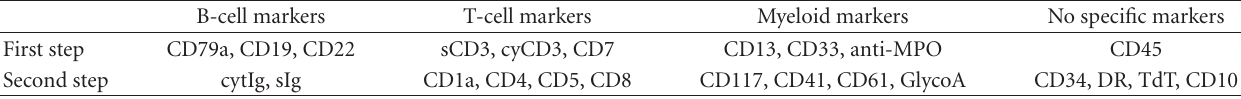
Table 1: Panel of Monoclonal Antibodies used in this study for immunophenotypic acute leukemia characterization.